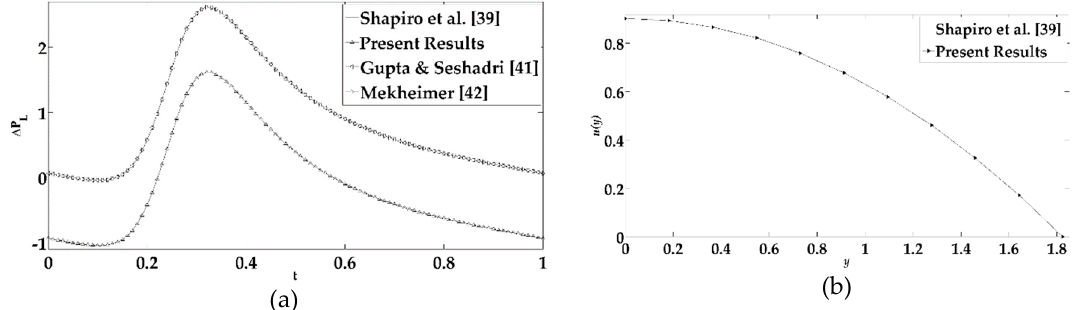
Figure 6. Friction force for various values of 𝐺𝑟 (cid:3047) and 𝑀 .